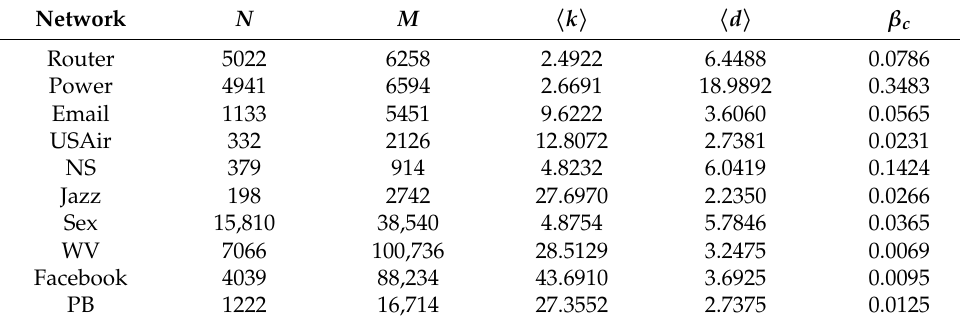
Table 4. The topological features of ten real-world